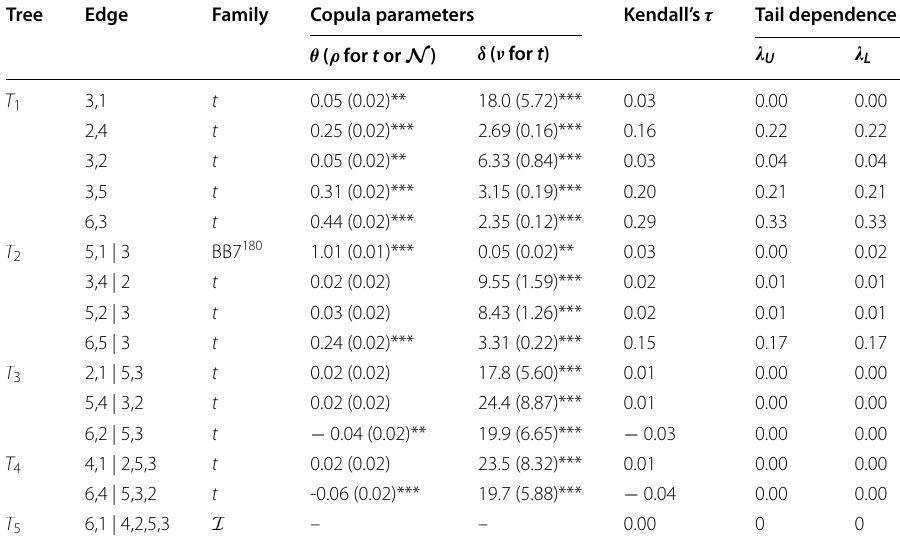
Table 10 Full estimation results of the R-vine copula for BRICS